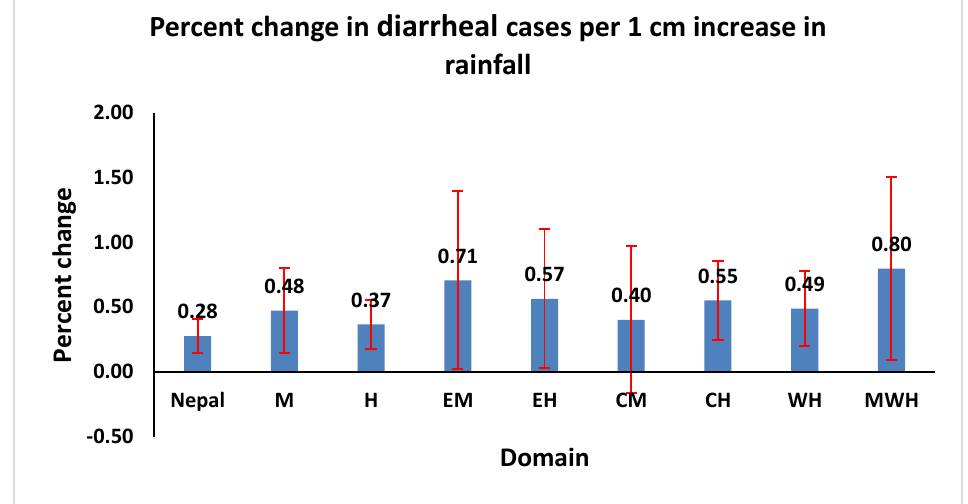
Figure 5. Percentage change in diarrheal cases per 1 cm increase in rainfall in eight eco-development regions, from July 2002 and June 2014. Note: data in the chart only include the domains that show significant effects. The projections were based on coefficients from negative binomial time-series GLMs.